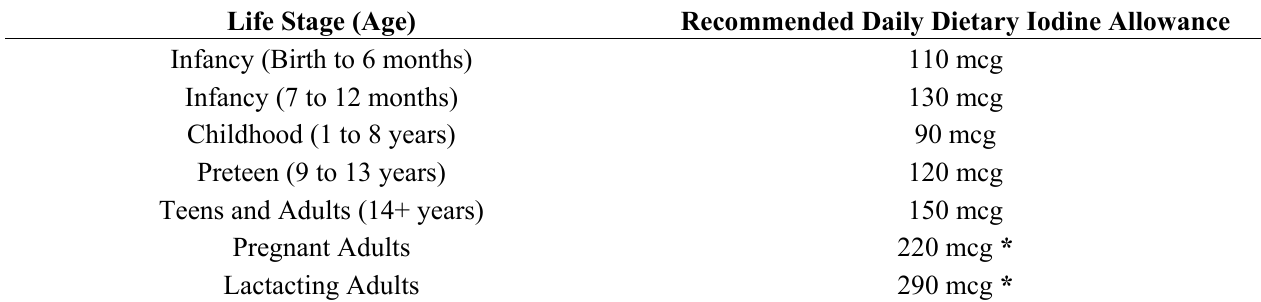
Table 10. Life-Stage Recommended Dietary Iodine Intake (Likely